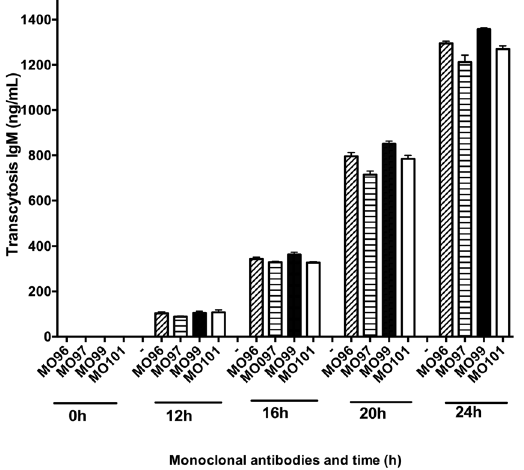
Figure 1. Transcytosis of HIV-1 from the apical to the basolateral side of the polarized epithelial cell membrane. The kinetics of the HIV-1 envelope specific human IgM MoAbs MO96, MO97, MO99 and MO101 transcytosis from the basolateral to apical side in the Transwell cell culture system using the human epithelial cell line Caco-2-pIgR + . The levels of transcytosed IgM MoAbs in the apical medium over the 24 h study period was assessed by gp160 MoAb reactive ELISA. Shown are median IgM transcytosis activity (Median and range). N = three separate experiments/monoclonal antibody